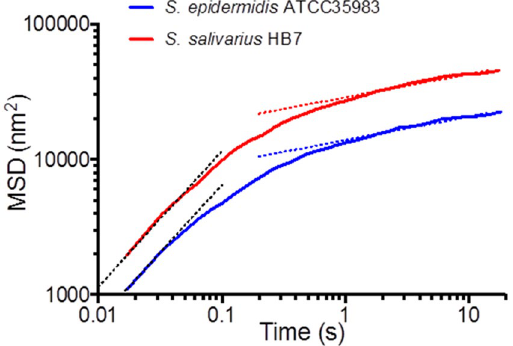
Figure 3. Mean Squared Displacement (MSD) as a function of time for two different bacterial strains involved in this study. Black dotted lines represent MSD(t) = A × t α (see also Eq. 4) corresponding with α -values equal to unity, while colored dotted lines are fitted to measured MSD values for t > 5 s (for α -values see also Table